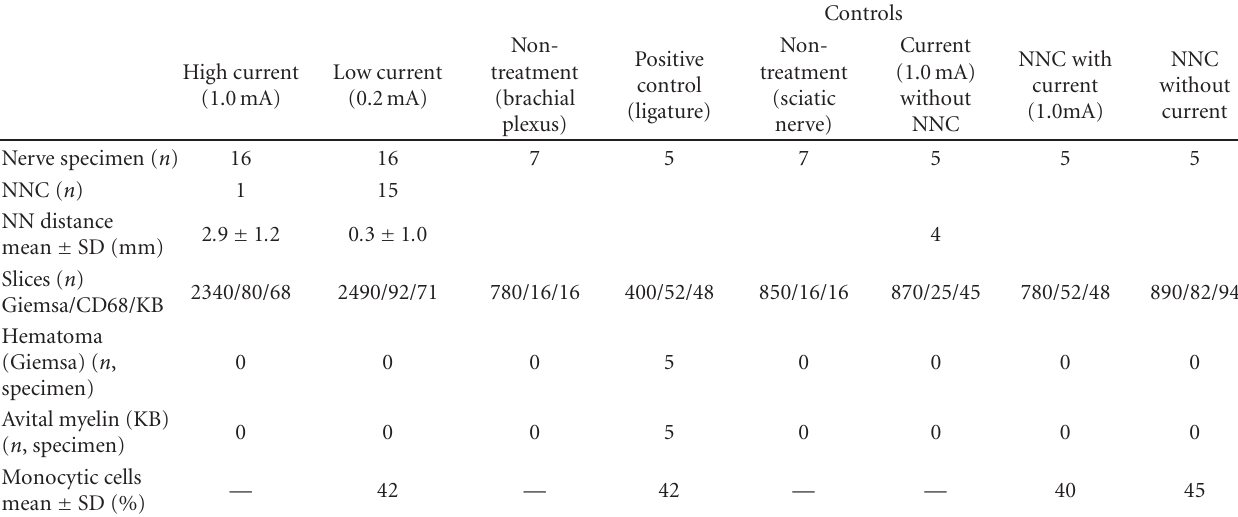
Figure 2: (a) Needle tip to nerve contact following needle placement with low threshold current (0.2mA). The needle tip is located adjacent to nerve epineurium. (b) Distant needle placement with high threshold current (1.0mA). A needle tip to nerve proximity of 2 mm was measured. N, radial nerve. Table 2: Treatment groups and controls. NNC, Needle-nerve contact; NN, needle-nerve; Giemsa, staining according to the Giemsa method; CD68, specific staining of CD68 positive leucocytes (macrophages) applying immunohistochemistry [10]; KB, myelin staining according to the Kluver-Barrera method [11, 12]; SD, standard